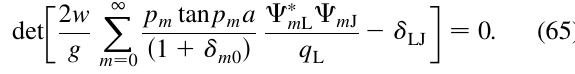
meter in the y direction is plotted for d=g (cid:5) 0 : 1 and (cid:1)=g (cid:5) 0 : 25 . We have also plotted gain calculated by the approxi- mate solution (56) (dashed line). As we see, the numerical